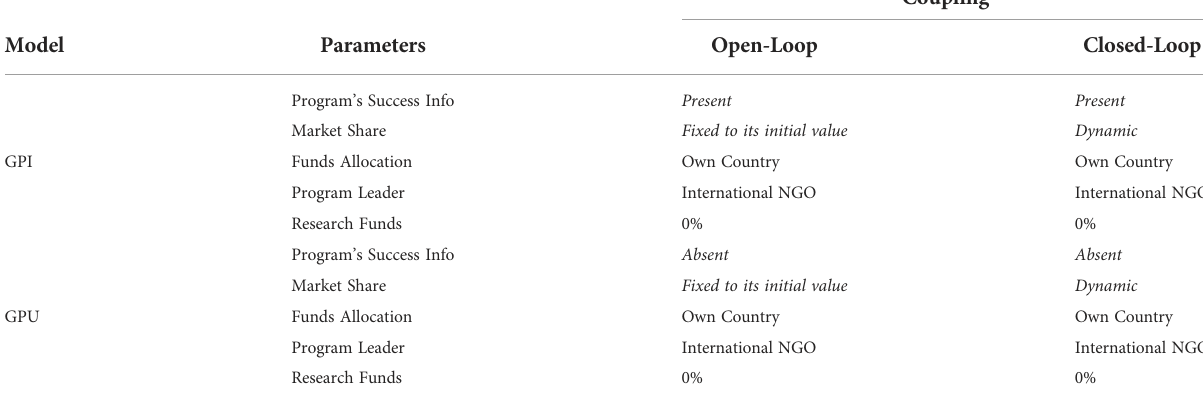
TABLE 1 Model con fi gurations to compare ecological outcomes of an open-loop versus a closed-loop coupling using two different behavioural models, General Public Informed (GPI) and General Public Uninformed